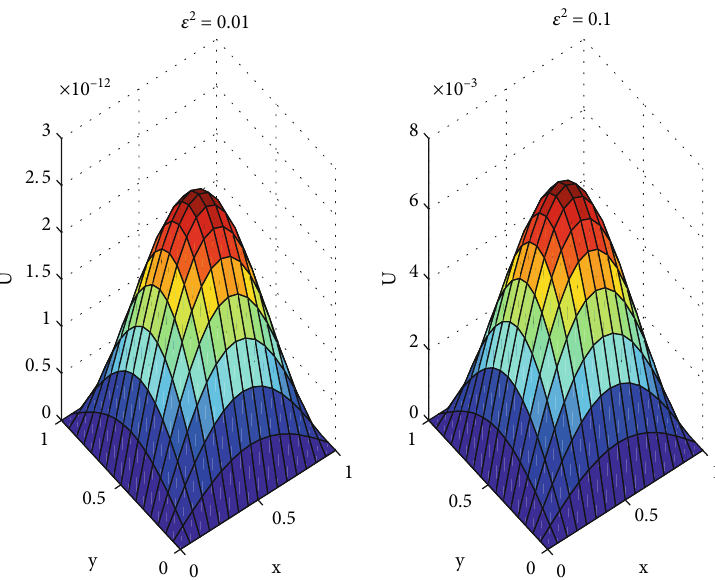
Figure 5: Temperature images with di ff erent relaxation parameters when D = 1 , h = 1/16 and 1/320 .